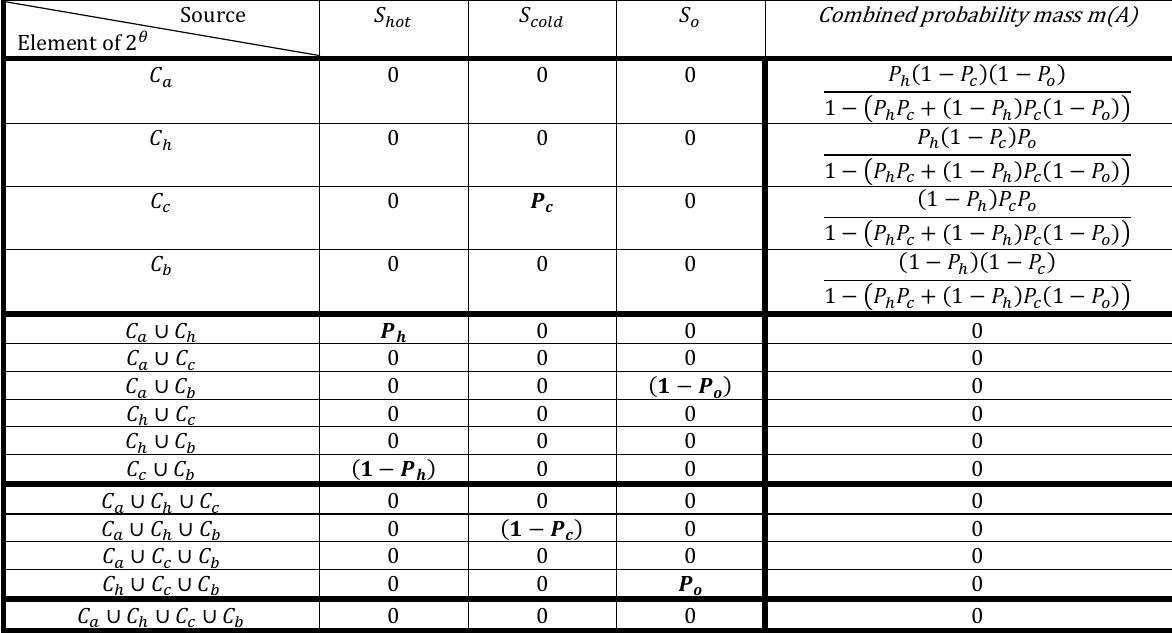
Table 1 Probabilty masses of 𝐴 ∈ 2